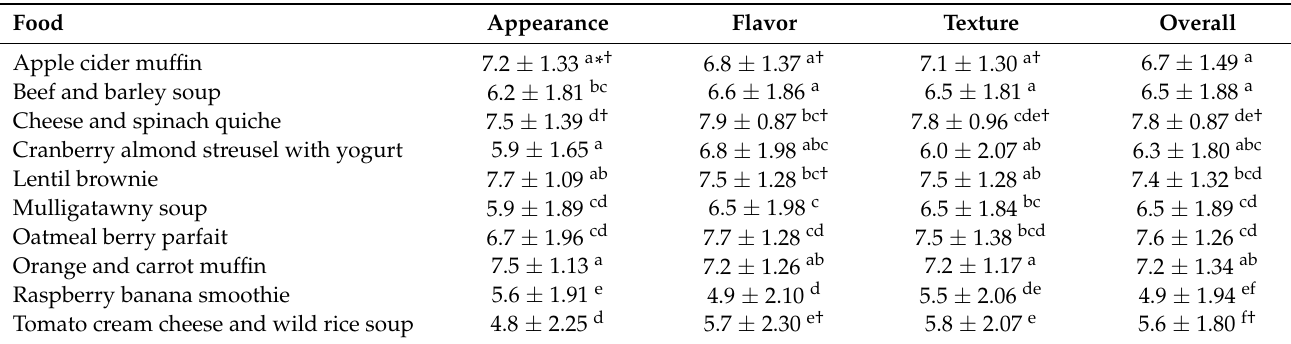
Table 3. Mean hedonic scores for sensory evaluation without nutrition and health information about nutrient-dense foods. A 9-point hedonic scale was used (1 = dislike extremely, 5 = neither like nor dislike, 9 = like